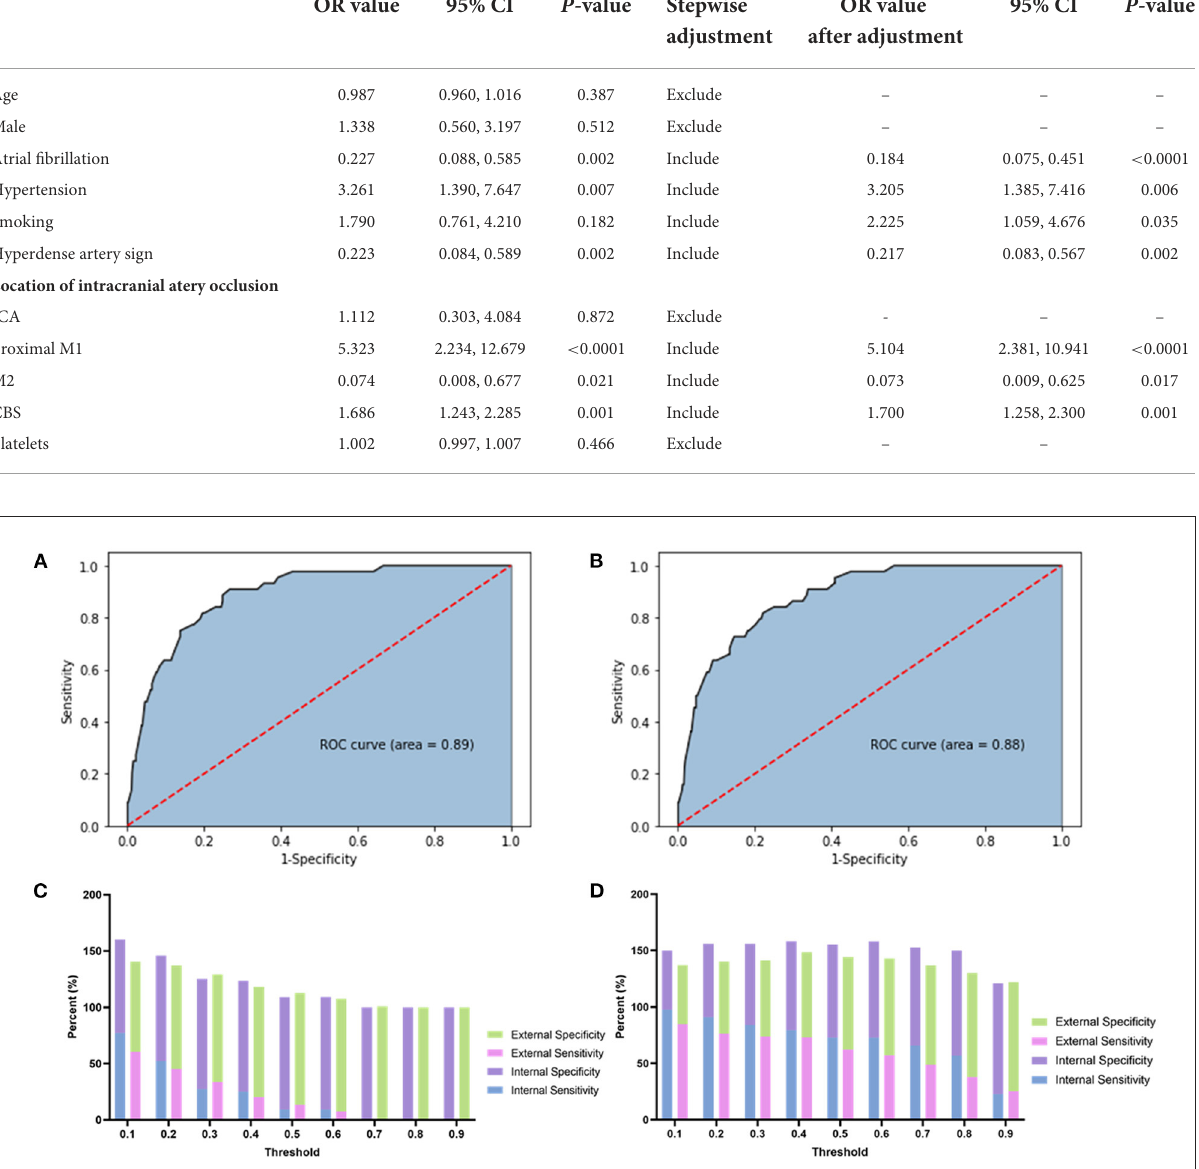
FIGURE1 This figure showed the ROC, sensitivity, and specificity of each model. (A) The ROC of the original prediction model. (B) The ROC of the predictive regression model after SMOTE adjustment. (C) The stacked bar chart of the sensitivity and specificity of the original prediction model. (D) The stacked bar chart of the sensitivity and specificity of the adjusted prediction